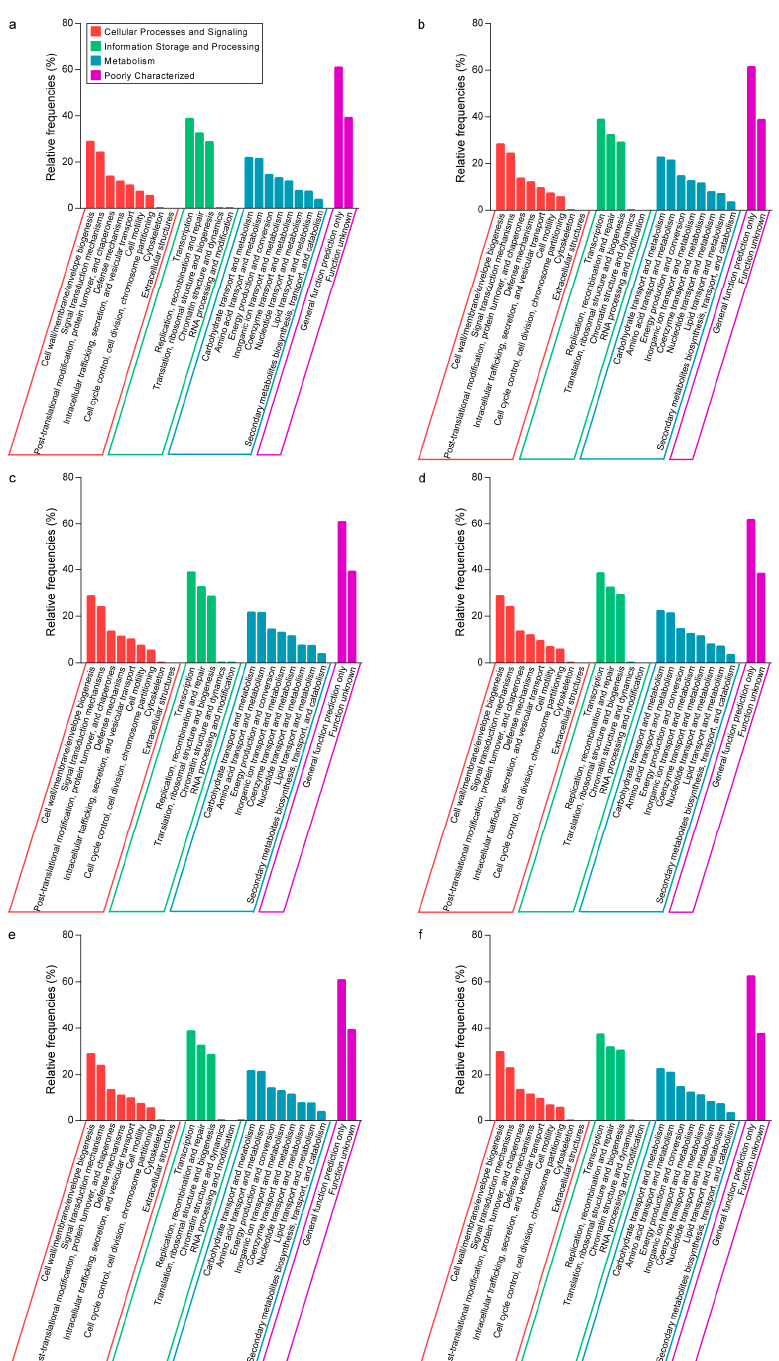
Figure 5. The relative frequencies of matched reads assigned in cluster orthologous groups (COGs) in camel feces. Four function categories in COG are showed here; ( a – f ) represent for the relative frequencies of control, Group A, Group B, Group C, Group D, Group E, Group F, respectively.